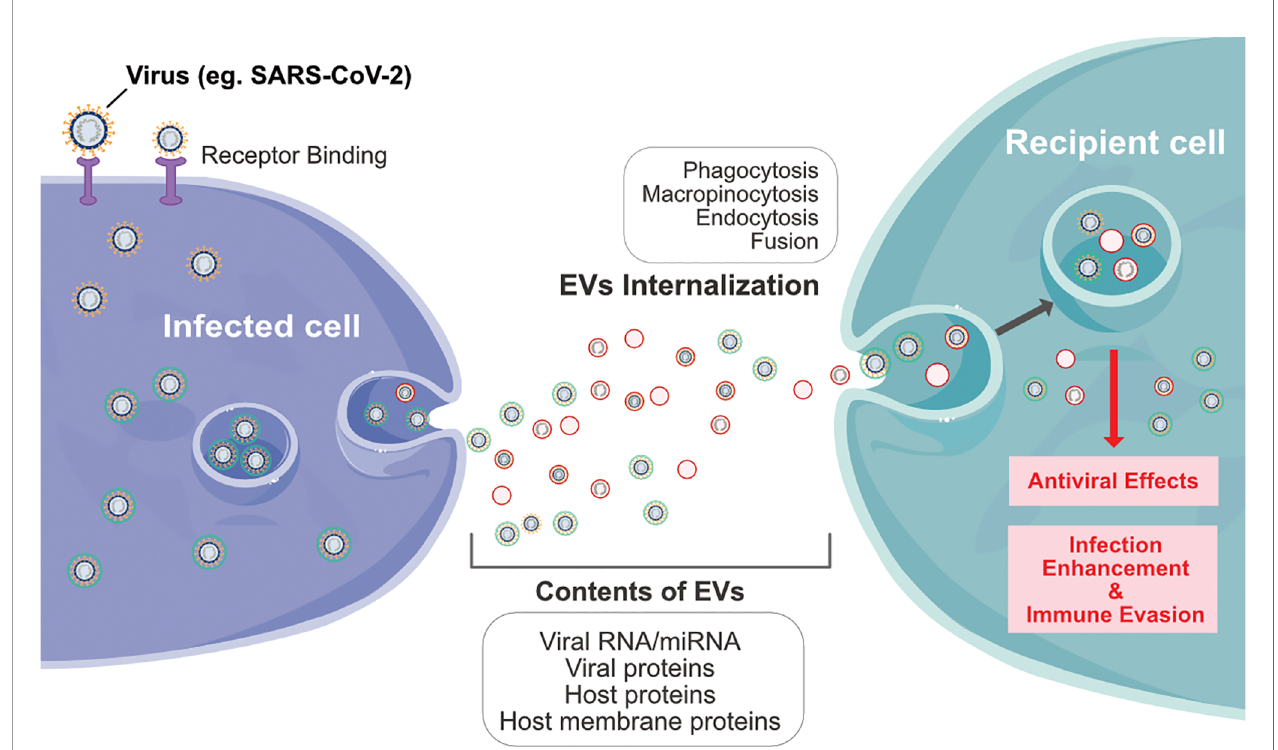
FIGURE 3 | Schematic diagram represents interplay between infected cells and recipient cells through extracellular vesicles by various processes such as phagocytosis, macropinocytosis, endocytosis and fusion of viral